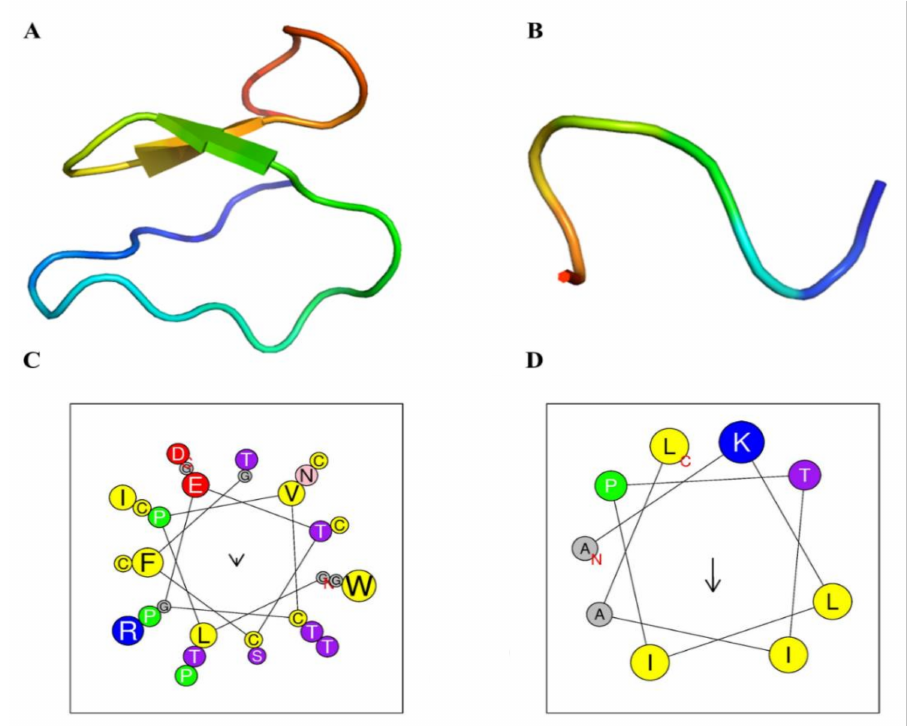
Figure 1. Three-dimensional (3D) structures and helical wheel projections of Kalata B1 and RcAlb - PepIII. Comparison between 3D structures of Kalata B1 ( A ) and RcAlb -PepIII ( B ) where both peptides presented unordered structures. The helical projection of Kalata B1 ( C ) and RcAlb -PepIII ( D ) revealed the higher complexity of the Kalata B1 structure compared to RcAlb -PepIII. The HeliQuest site was used for the construction of diagrams and projections and the PEPFold server to produce 3D structures. The hydrophobic residues are represented in yellow, apolar residues are in silver, while positively charged residues are in blue, and the polar residues are in violet and magenta. The arrows represent the helical hydrophobic